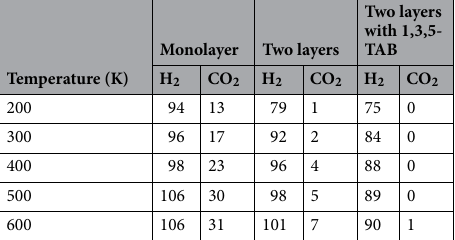
Table 2. Number of the gas molecules passing through the GDY-H membrane in the range of 200–600 K.